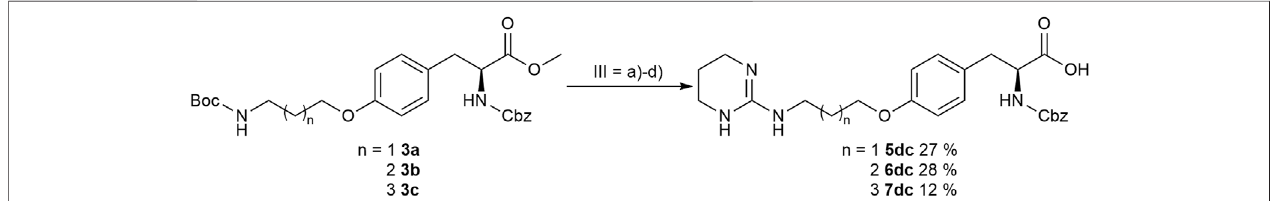
FIGURE 6 | Synthesis of Cbz containing RGD mimetics 5dc, 6dc and 7dc. Reagents and conditions: a) 4 M HCl in dioxane, DCM, RT; b) 2-bromopyrimidine (Pyr/ THP), triethylamine, methanol, 80 ° C, o.n.; c) LiOH, water, methanol, RT; and d) 2-bromopyrimidine, Pd/C, H 2 , AcOH, HBr, water, methanol, RT,